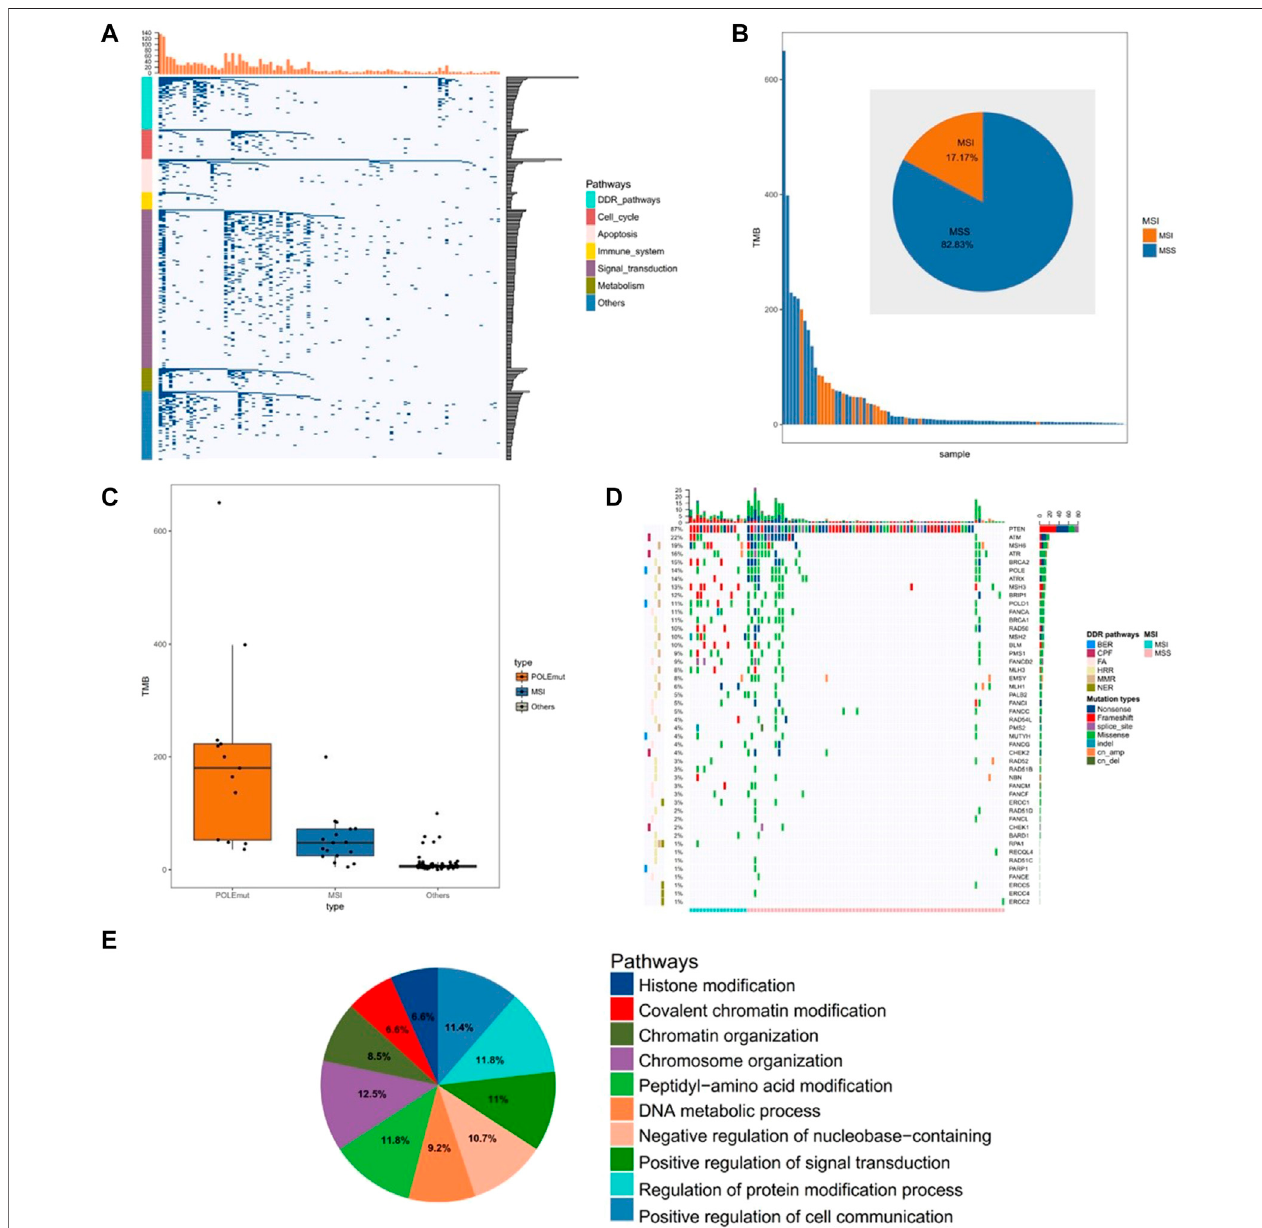
FIGURE 1 | Comprehensive analysis of the gene mutations in endometrial cancer. (A) Unsupervised clustering of gene mutations in endometrial cancer. Samples are presented in columns, and the 520 cancer-related genes are presented in rows. (B) The analysis of microsatellite instability in 99 samples (C) The analysis of tumor mutationalburden levelinthePOLE(DNApolymeraseepsilon,catalytic subunit) mutantgroup,MSI(microsatelliteinstability)group, andothergroups (D) Theanalysisof mutated genes related to the DDR pathway (E) The pathway analysis of signi fi cantly mutated genes (mutation > 10%).